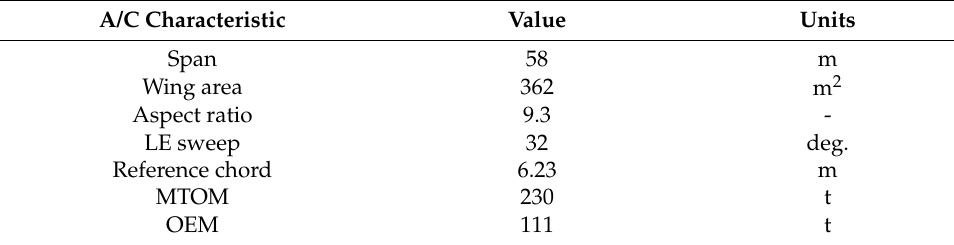
Table 1. Main characteristics of the